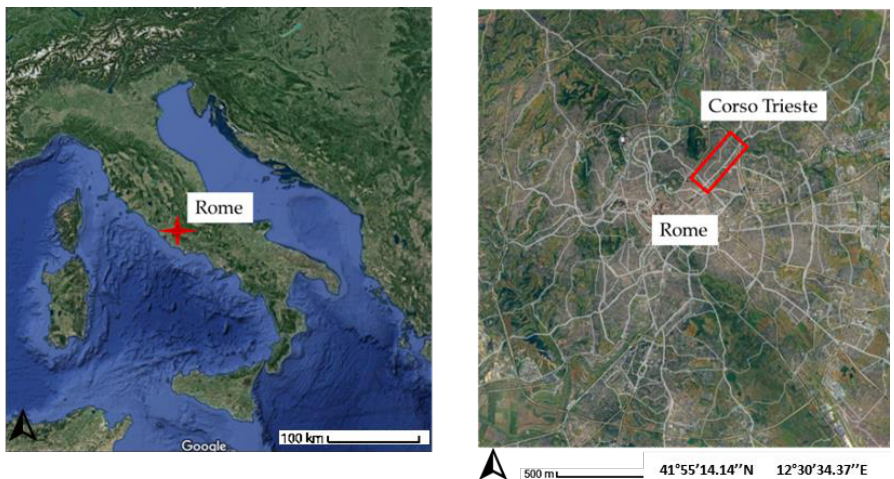
Figure 3. ( Left ): Position of the city of Rome in central Italy. ( Right ): Focus on Rome with indication of the Corso Trieste (from Google Earth).